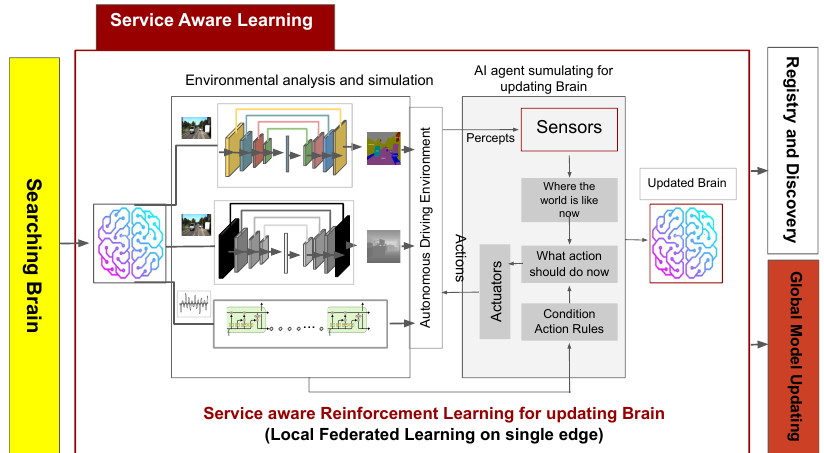
Figure 5. Service aware knowledge updating in the edge